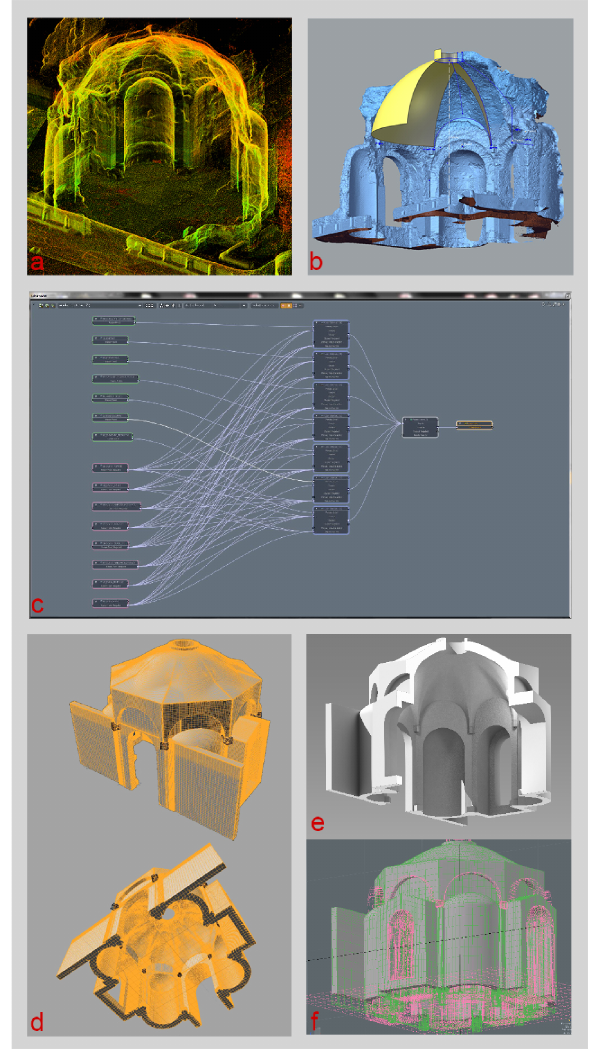
Figure 2. Case A workflow applied to the Vestibule of the Water Court (Vestibolo di Piazza d’Oro), Hadrian’s Villa.